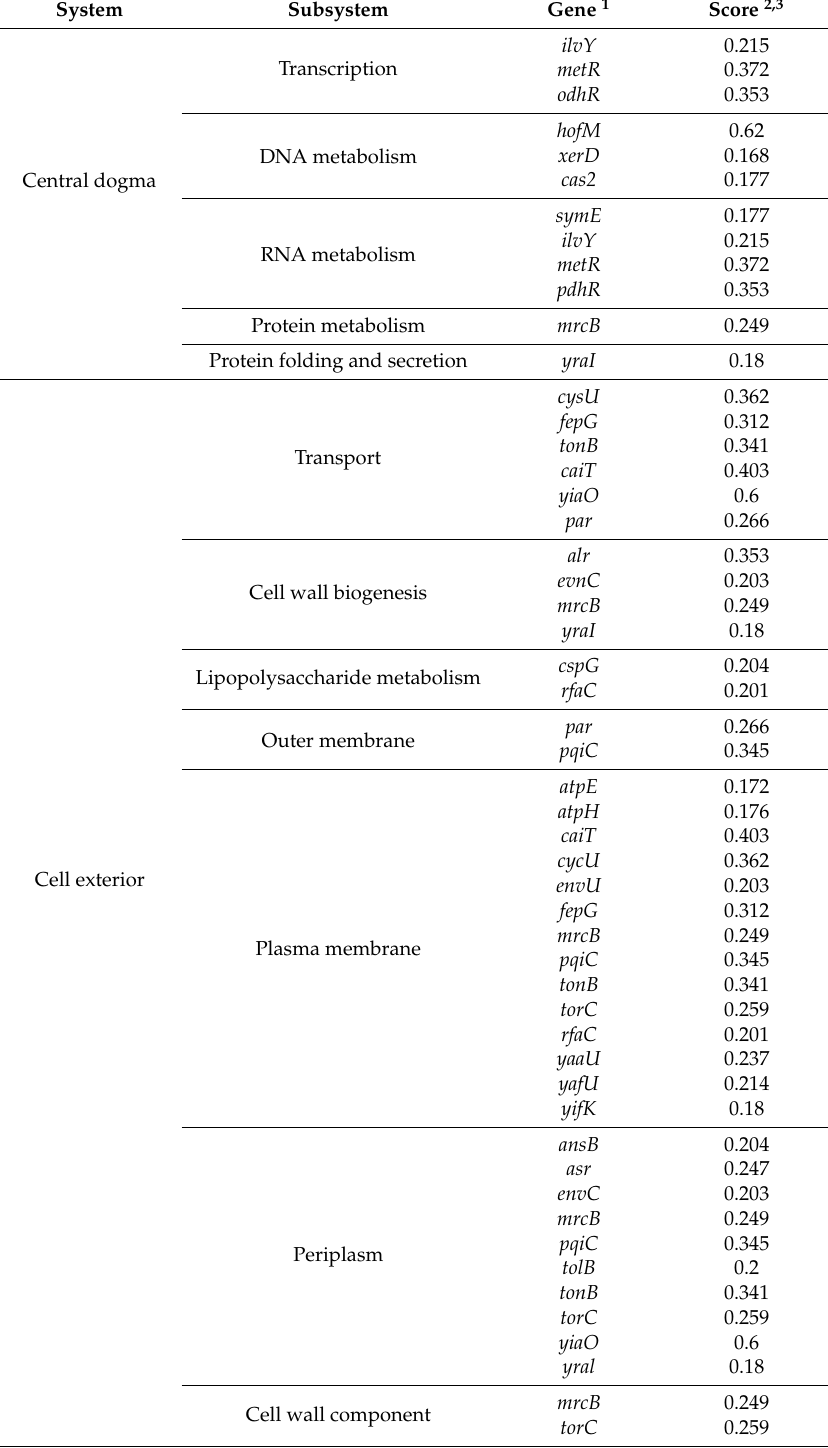
Table 2. Ga-resistant hits organized according to system and subsystem mined using the Omics Dashboard (Pathway Tools), which surveys against the EcoCyc Database; genes represent resistant hits with scores